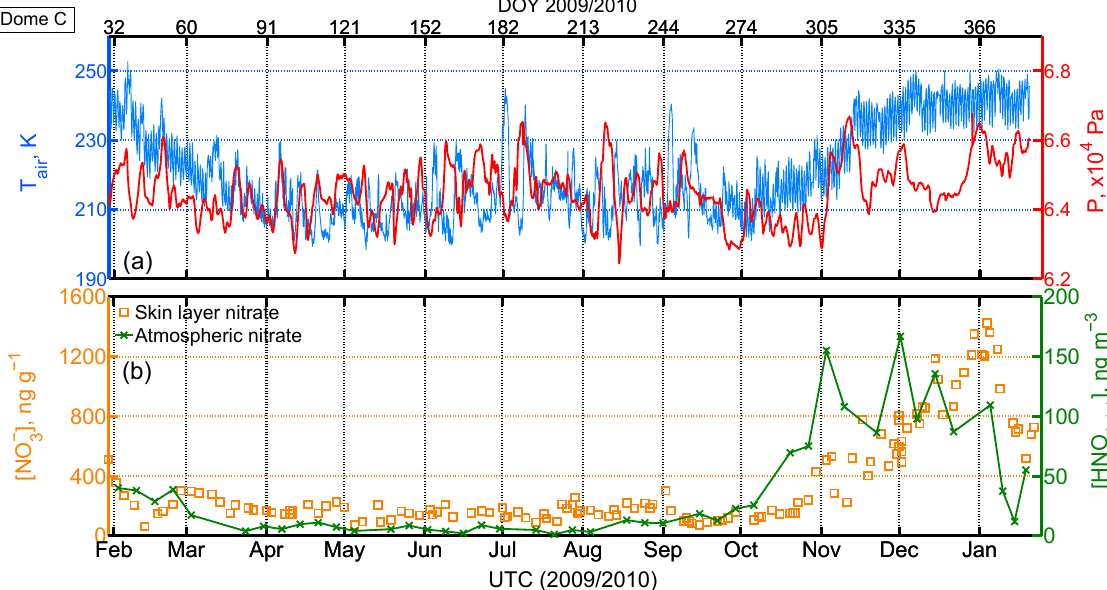
, i.e. sum of the 3